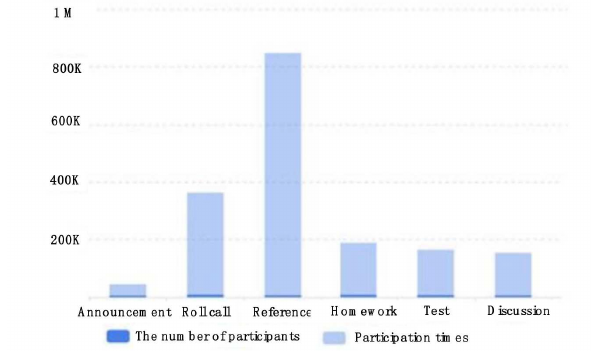
Fig. 7 The interaction between teachers and students on the